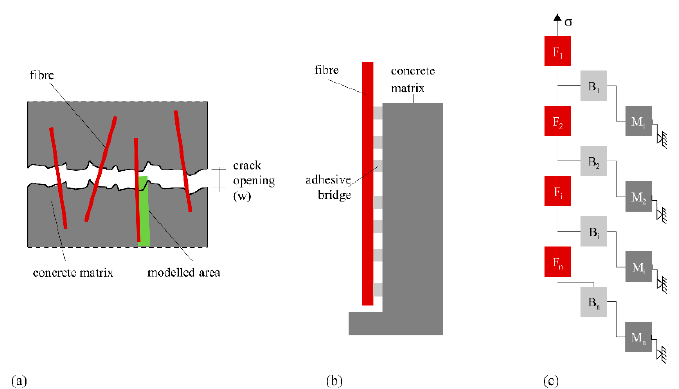
Figure 12. Schematic setup of the modelling approach with ( a ) definition of the modelled region, ( b ) physical model of fibre, matrix and interphase and ( c ) arrangement of idealised entities for rheological modelling.